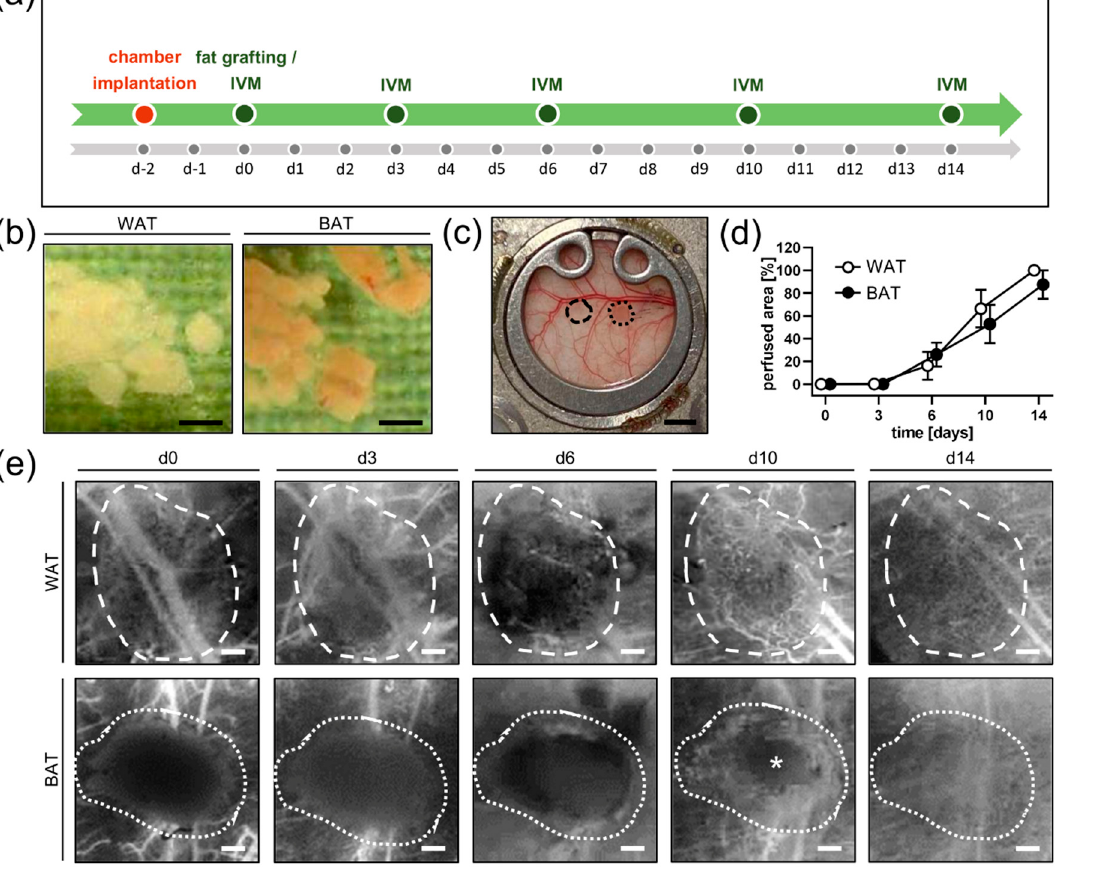
Figure 1. ( a ) Study design of the performed experiments. The implantation of the dorsal skinfold cham- ber was executed 48 h prior to fat grafting into C57BL/6N mice ( n = 8). Graft vascularization was re- peatedly analyzed by means of intravital fluorescence microscopy (IVM) on day 0, 3, 6, 10, and 14 after transplantation. ( b ) WAT and BAT samples excised from C57BL/6N donor mice and minced for grafting. Scale bar: 500 μ m. ( c ) Overview of the observation window of a dorsal skinfold chamber with a WAT (broken line) and a BAT (dotted line) graft directly after transplantation. Scale bar: 2 mm. ( d ) Perfused area of WAT ( n = 8) and BAT ( n = 8) grafts on day 0, 3, 6, 10, and 14 after transplantation, as assessed by intravital fluorescence microscopy. Mean ± SEM. ( e ) Representative intravital fluorescence microscopic images (blue light epi-illumination with 5% FITC-labeled dextran for contrast enhancement) of a WAT (broken line) and a BAT (dotted line) graft over the course of the 14-day observation period. Note that the center of the BAT graft still contains a non-vascularized area (asterisk) on day 10, whereas the WAT graft is already fully vascularized at this time point. Scale bar: 200 μ m.